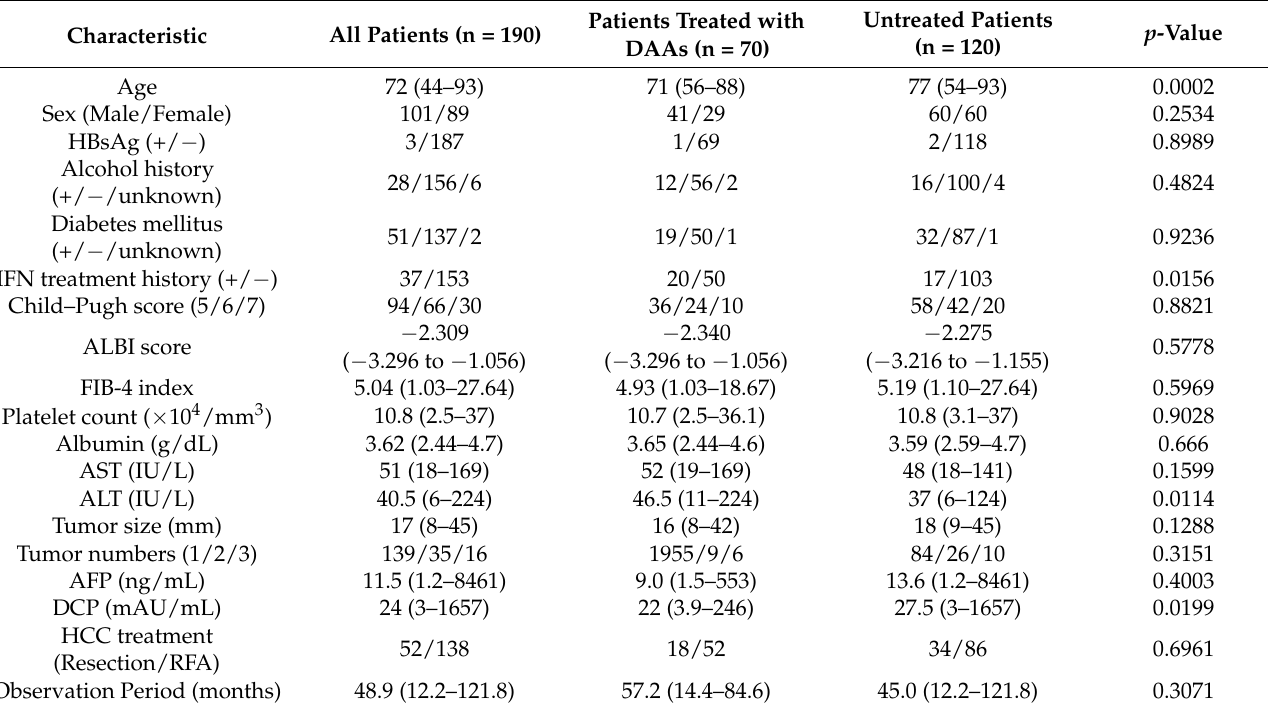
Table 1. Patient characteristics before propensity score